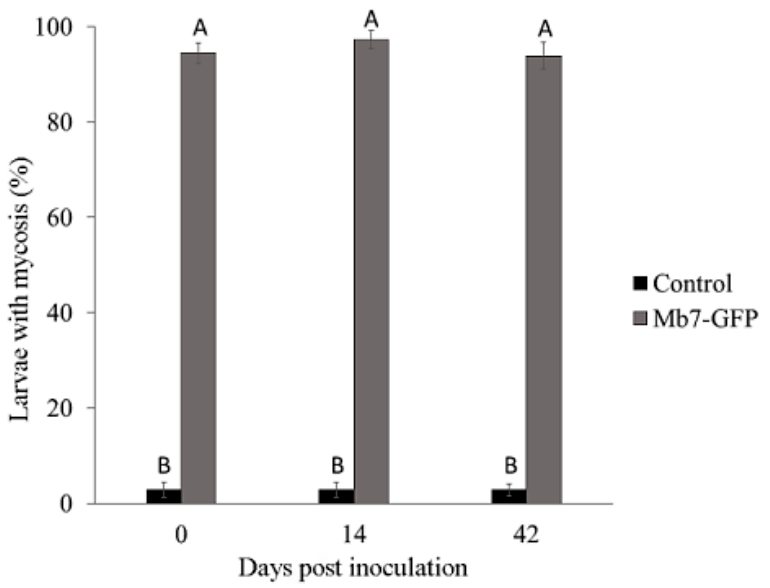
Figure 8. Rate of mycosis in G. mellonella larvae exposed to soil samples from potted rootstocks at different times after EPF application in 2018 trials. Data of two rootstocks (2729 and GF677) are combined. Values sharing a common letter are not significantly different. Two-factor ANOVA was performed with replications ( p = 0.0001).